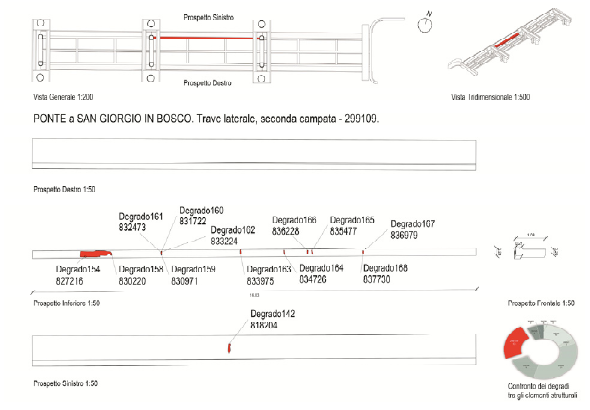
Figure 8. Representation of the current condition of bridge parts